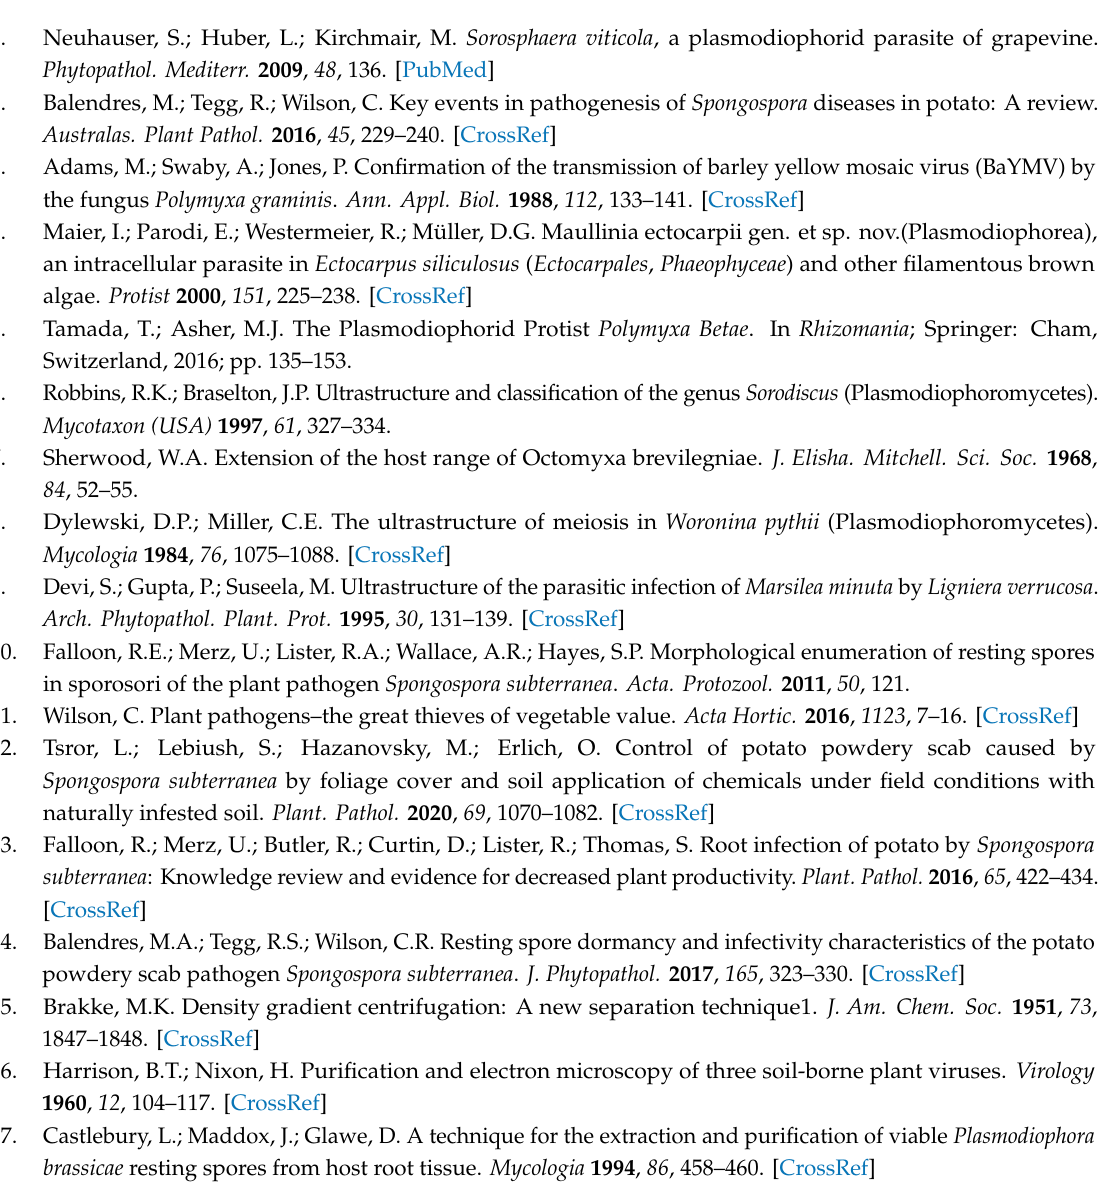
Supplementary Materials: Excel S1: List of the proteins identified using the SP3 method, Excel S2: List of the proteins identified using the S-Trap method, Excel S3: T-test results (purified vs. non-purified). The mass spectrometry proteomics data were deposited to the ProteomeXchange Consortium via the PRIDE [46]